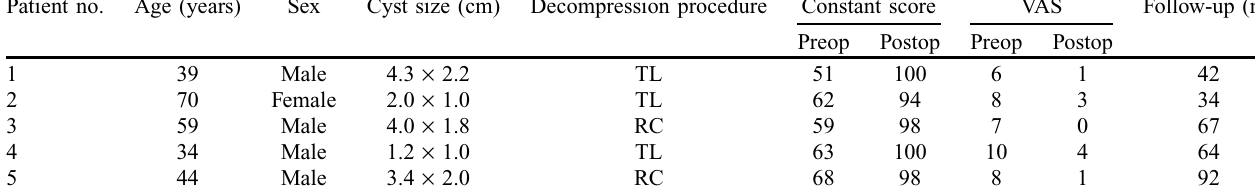
Table 1. Patient data. Patient no.